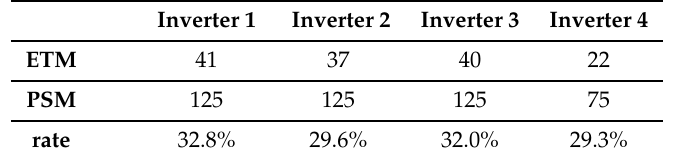
Table 2. Sampling number in Case B (event-triggered mechanism (ETM) vs. periodic sampling mechanism (PSM)).